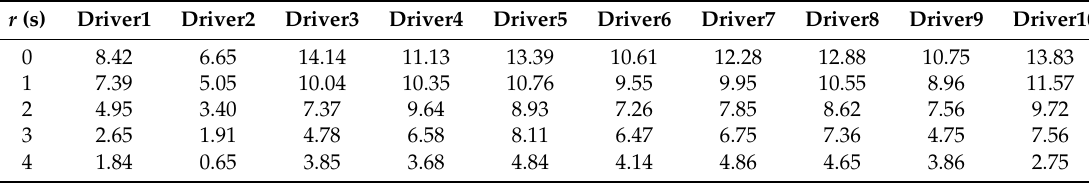
Table 11. False positive (s) of testing data